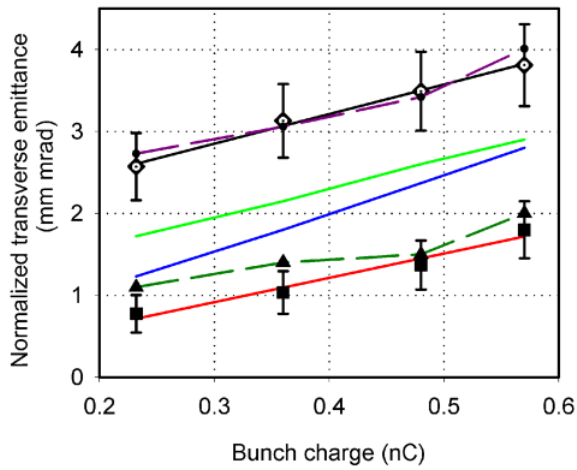
FIG. 4. (Color) Emittance as a function of bunch charge. Square markers indicate data for the regular beam; the red line shows best-fit data for a regular beam; the triangles with the dark green dotted line represent PARMELA simulations for a regular beam; the blue line is for an analytical estimate for the regular beam; the diamonds represent data for type 5; the black line is a best-fit curve for type 5; the circles with the dark pink dotted line show PARMELA simulation for type 5; the green line presents an analytical estimate for type